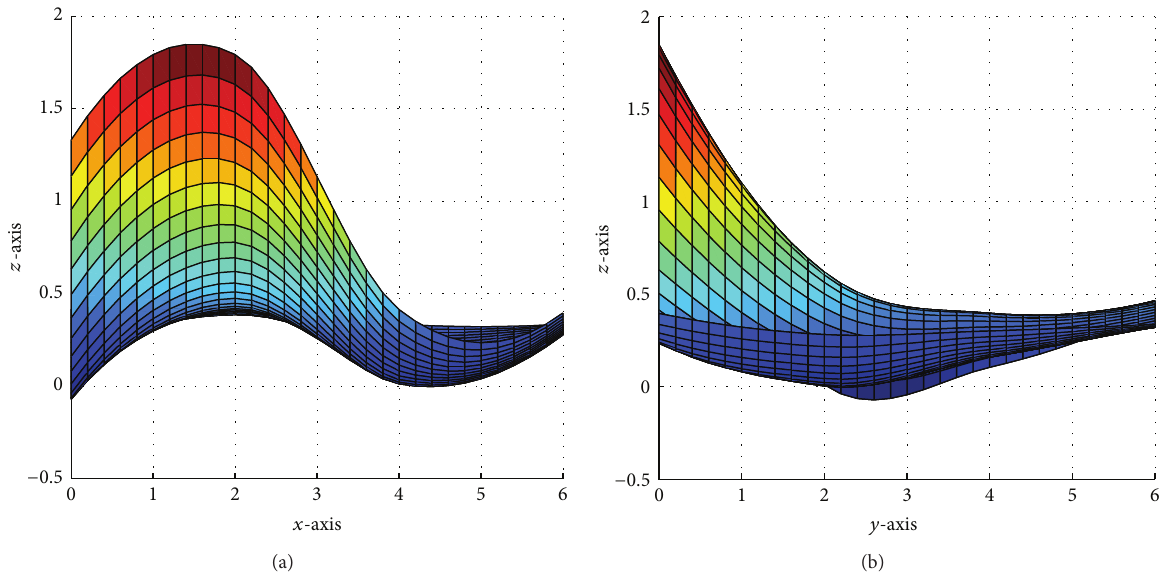
Figure 3: Bicubic Hermite surface: (a) 𝑥𝑧 -view and (b) 𝑦𝑧 -view for Figure 2, respectively.